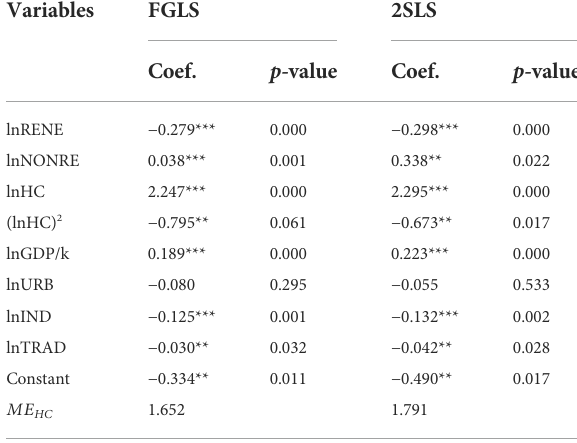
TABLE 10 Results of the nonlinear effect approach.